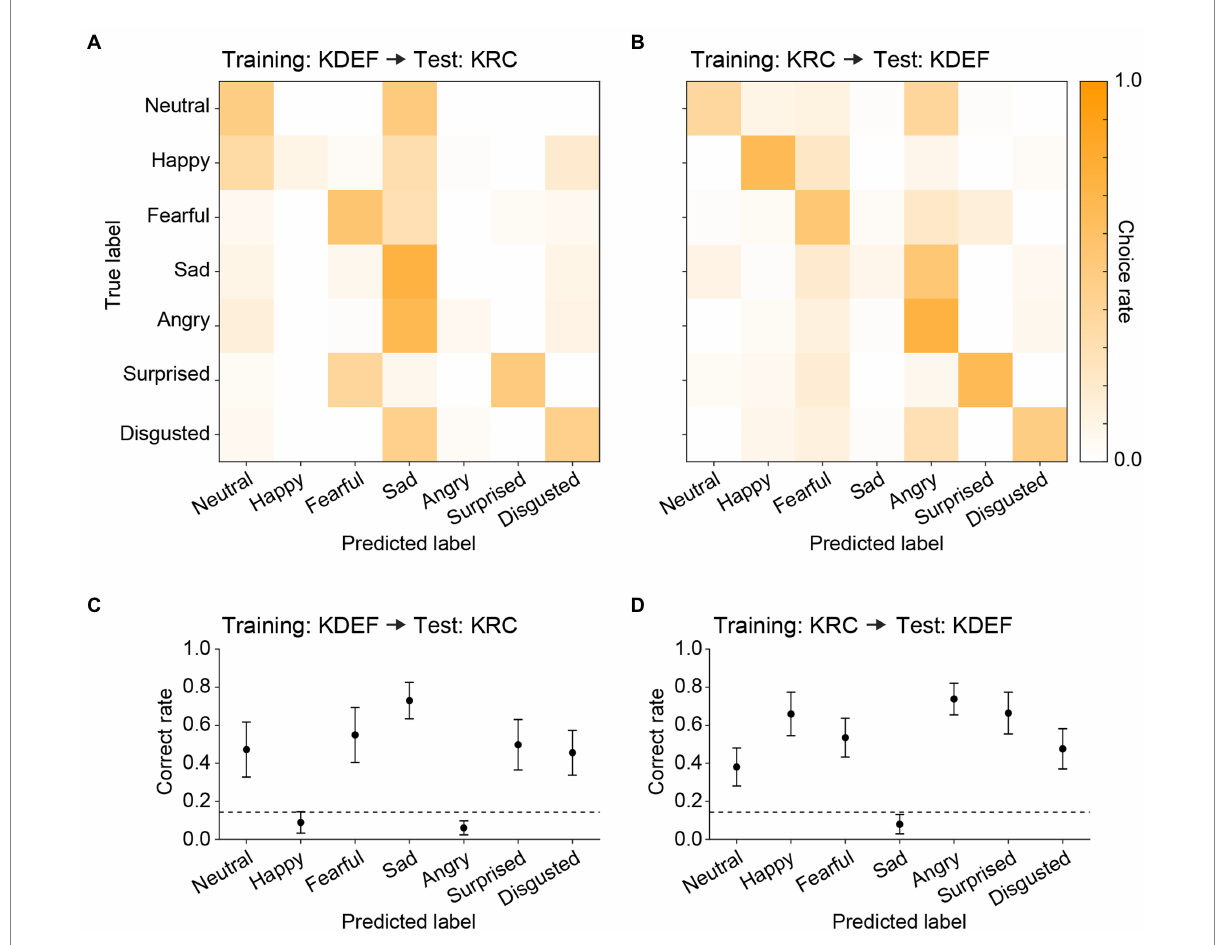
FIGURE 4 Classification performance in the database-swapped conditions. The confusion matrix (A) and correct rates (C) of the KDEF-trained CNNs when tested with the KRC database. The confusion matrix (B) and correct rates (D) of the KRC-trained CNNs tested with the KDEF database. Other conventions are the same as in Figure